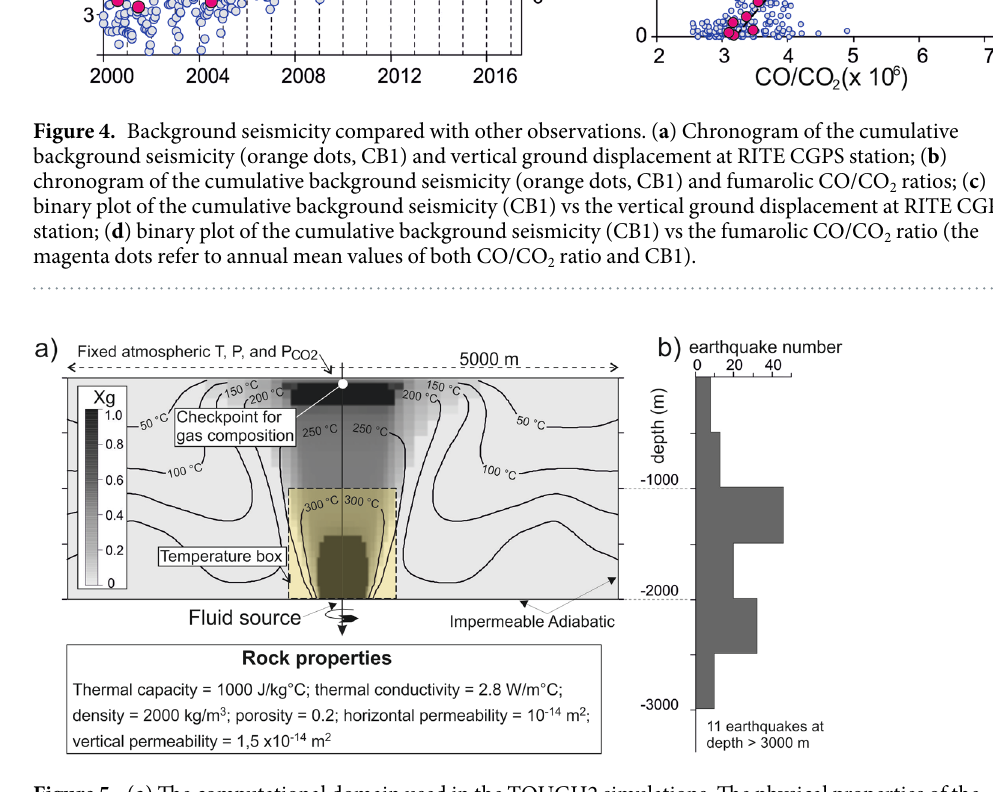
Figure 5. ( a ) The computational domain used in the TOUGH2 simulations. The physical properties of the rocks are homogeneous. The temperature (isolines) and the volumetric gas fraction Xg (different shades of gray) refer to steady-state conditions. The “checkpoint for gas composition” is the zone where the simulated CO 2 /H 2 O is compared with the measured ones 7 . The “Temperature box” (yellow rectangle above the injection zone) is the region where the average temperature is calculated during the simulations (redrawn from ref. 7). ( b ) depth of the best located earthquakes 9 excluded those occurred on the 7 th September 2009 (see Fig. 1). The depth scale in panel (b) corresponds to the one used in panel